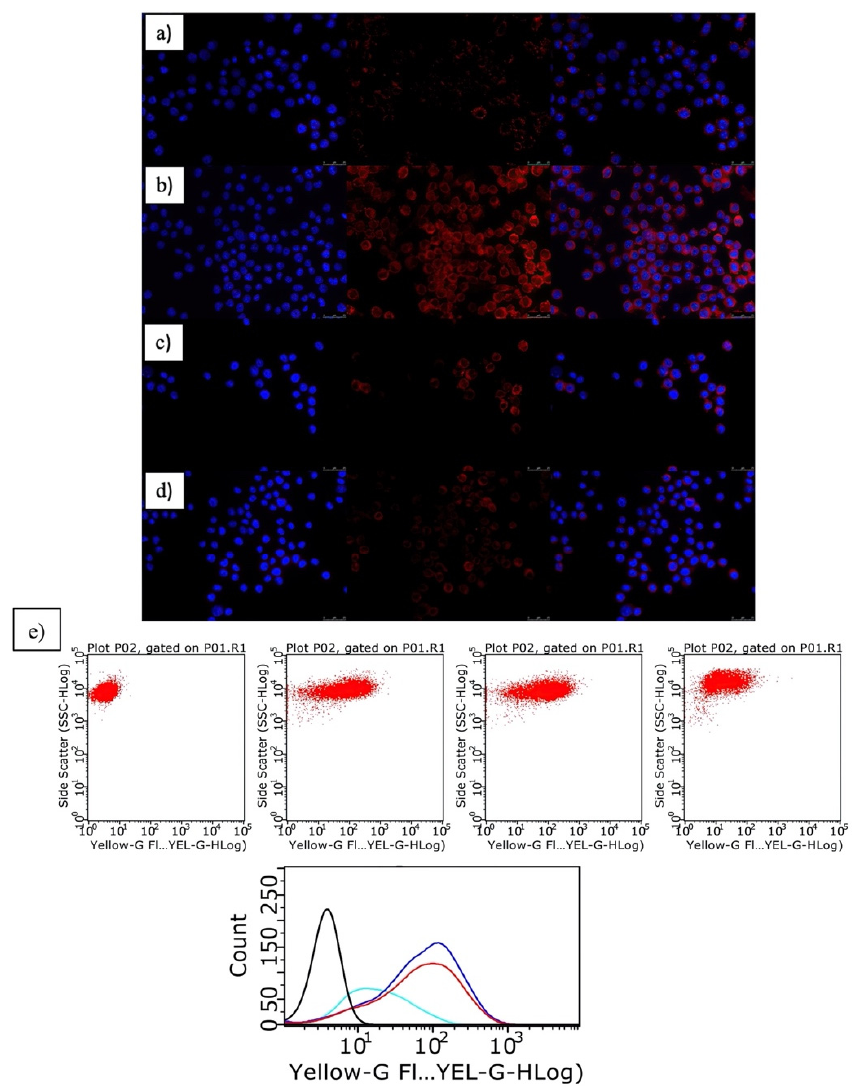
Figure 5. Ox-LdL by RAW 264.7 macrophages: ( a ) non-activated; ( b ) activated with 100 ng/mL LPS; ( c ) after administration of 1 × 10 10 NPs/mL ATOR-PLGA NPs (20 mM drug); ( d ) after administration of 5 × 10 10 NPs/mL ATOR-PLGA/miRNA NPs (20 mM drug–100 nM miRNA). From left to right: DAPI channel; Dil-ox-LdL channel; merge image. Scale is 25 mm. ( e ) Flow cytometry data of Dil-ox-LdL uptake in RAW cells: From left to right: bare, non-activated cells, bare, LPS-activated cells, and LPS-activated cells treated with 1.0 × 10 10 and 5.0 × 10 10 NPs/mL; bottom: fluorescence distribution of Dil-ox-LdL inside cells: (—) control, non-activated cells; (—) control, LPS-activated cells; LPS-activated cells treated with (—) 1.0 × 10 10 and (—) 5.0 × 10 10